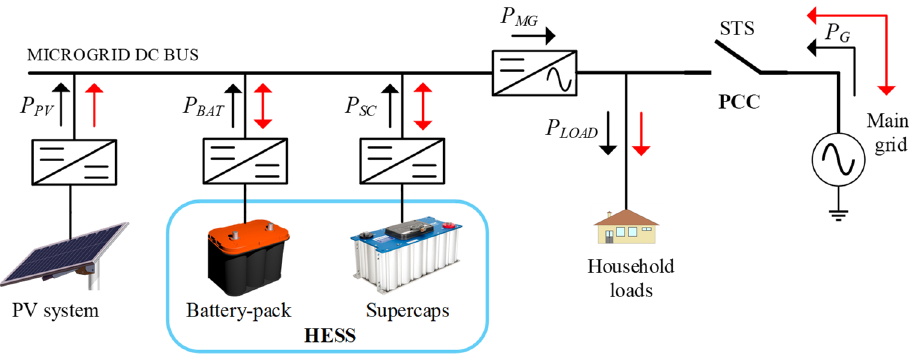
Table 1. Electrical characteristics of Shell SP150-P module at standard test conditions (STC).